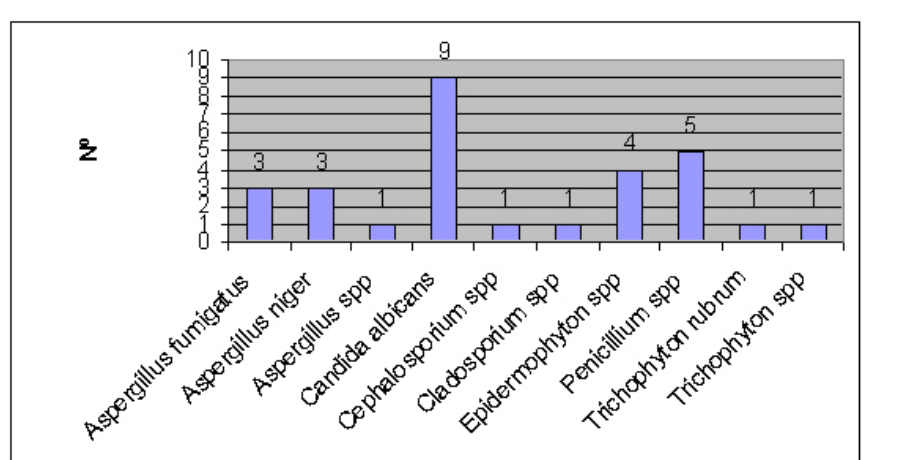
Figure 1: Frequency of fungi species reported in the hydrotherapy units evaluated in two counties from Rio de Janeiro State, Brazil.